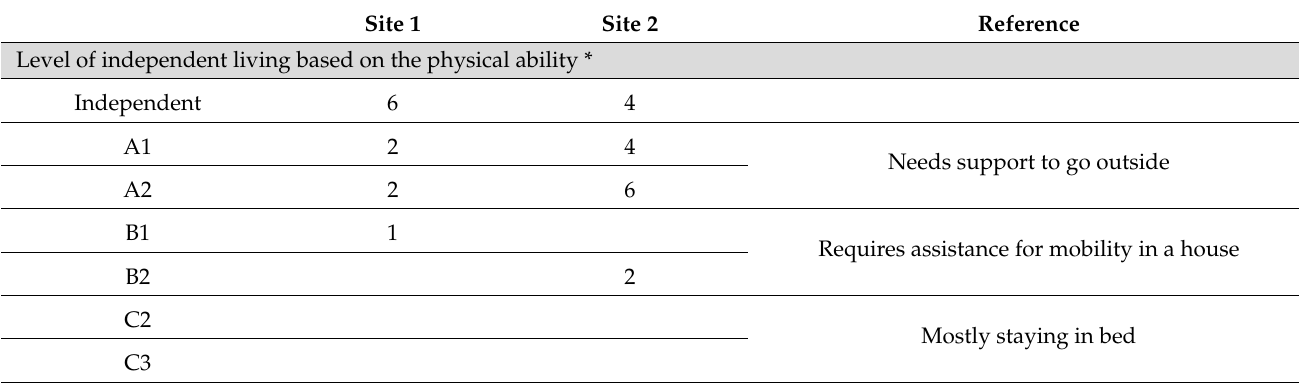
Table 2. Cont. Site 1 Site 2